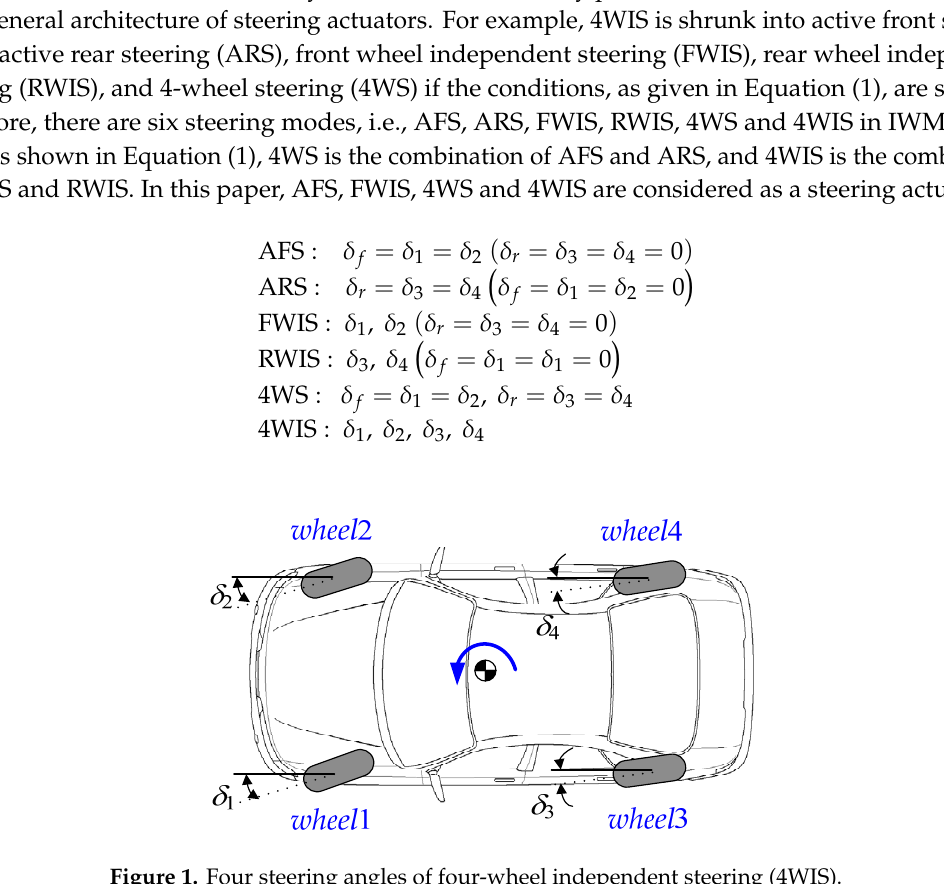
Figure 1. Four steering angles of four-wheel independent steering (4WIS).